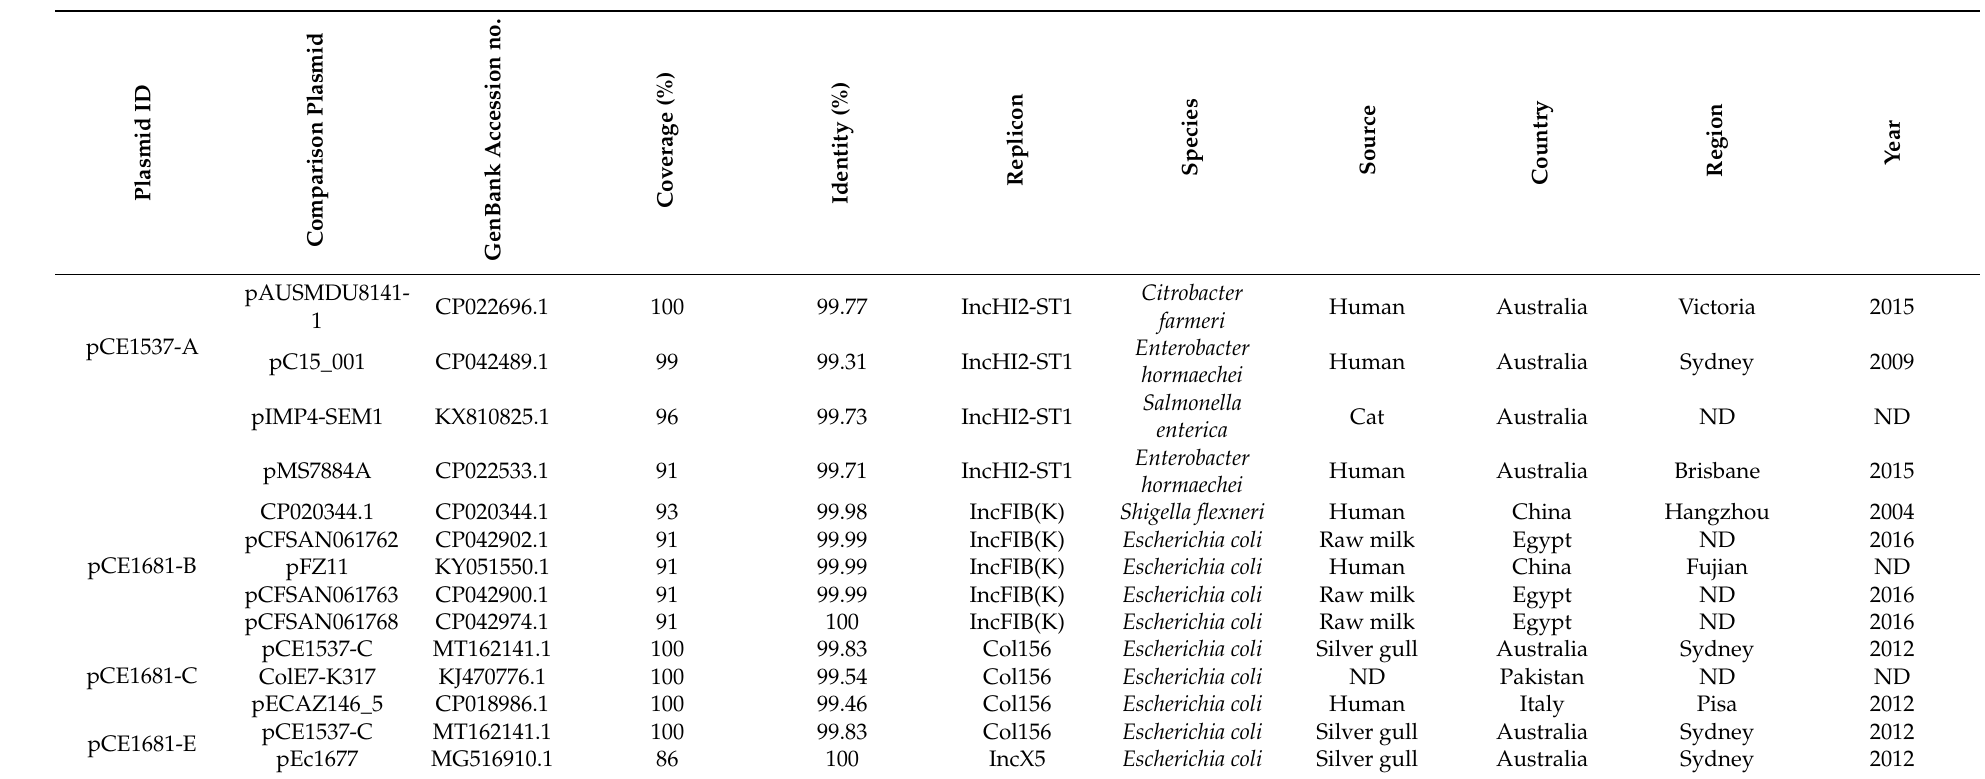
Table 2. Characteristics of plasmids used for comparison with plasmids pCE1537-A, pCE1681-B, pCE1681-E, and